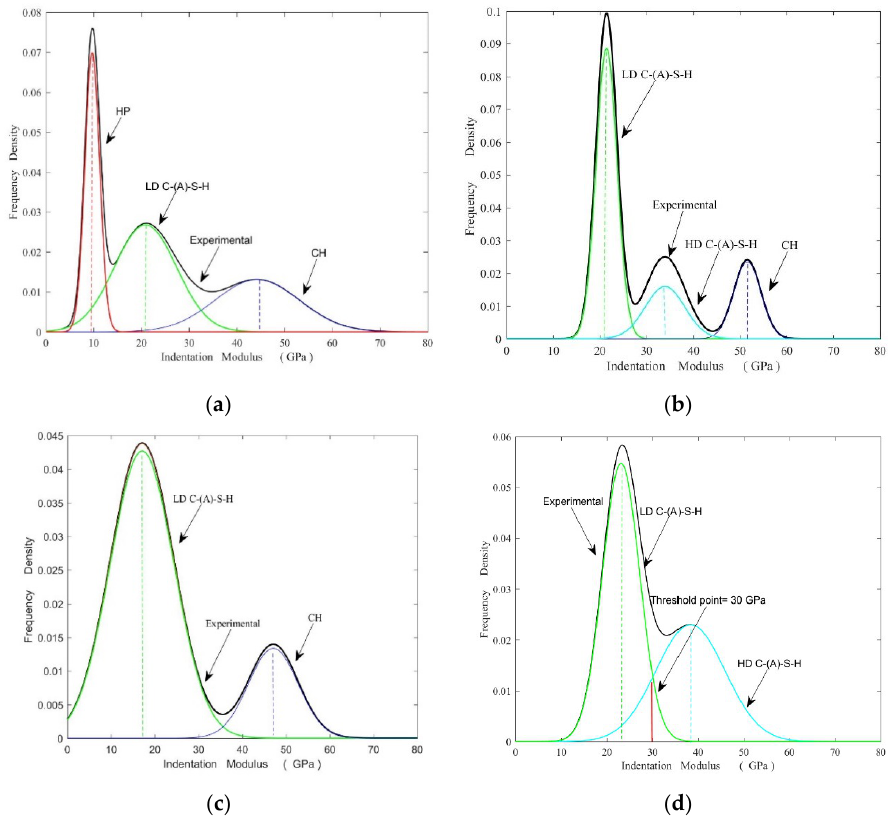
Figure 6. Nanoindentation point Gaussian fitting results of sample ( a ) CMH006, ( b ) CMS1028, ( c ) CMS0028, and CMH206 ( d ).